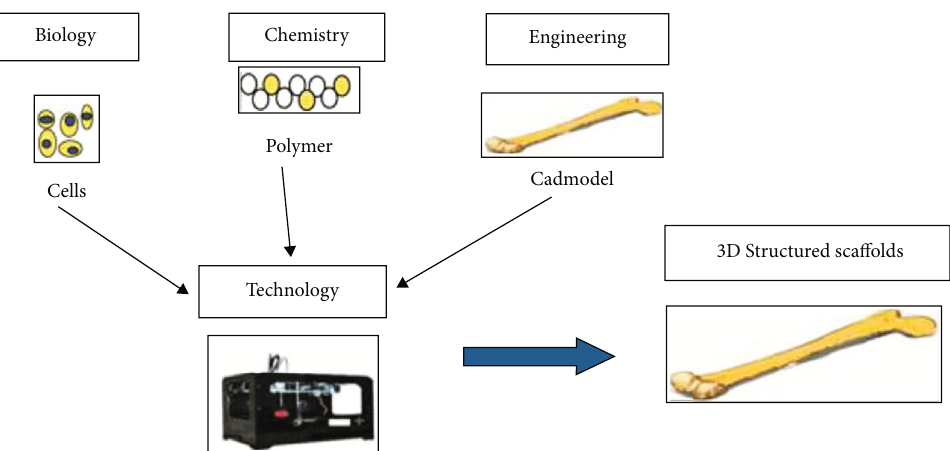
Figure 5: Representation of multidisciplinary fi elds used in the 3D printing technique for TE applications [136]. Table 2: Biopolymeric materials in tissue engineering and wound healing [146 – 155]. Biomedical fi eld